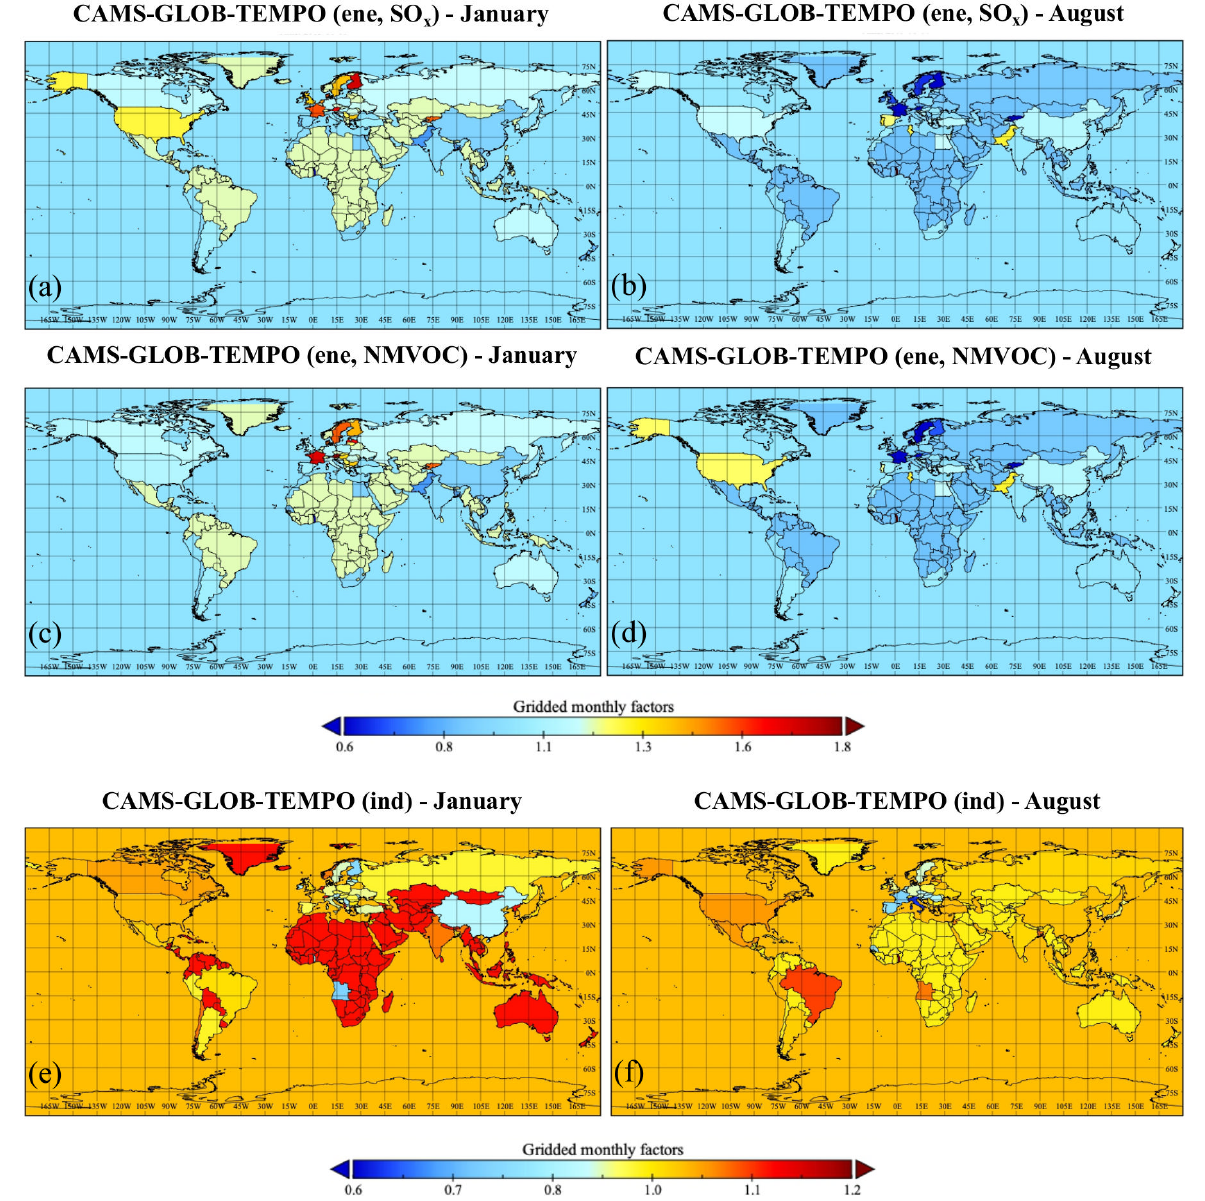
Figure 5. CAMS-GLOB-TEMPO (0.1 × 0.1 ◦ ) monthly scale factor maps for SO x (a, b) and NMVOC (c, d) energy industry (ene) emissions and for manufacturing industry (ind) emissions (e, f) for the months of January and August. Administrative boundaries are derived from the Micro World Data Bank (MWDB2,